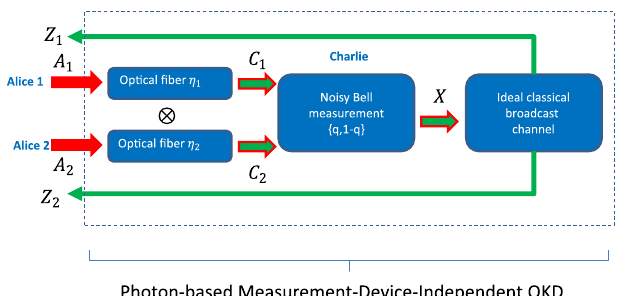
prototype.FIG. 4. Pictorial illustration of our photon-based MDI-QKD between two parties using the dual-rail encoding